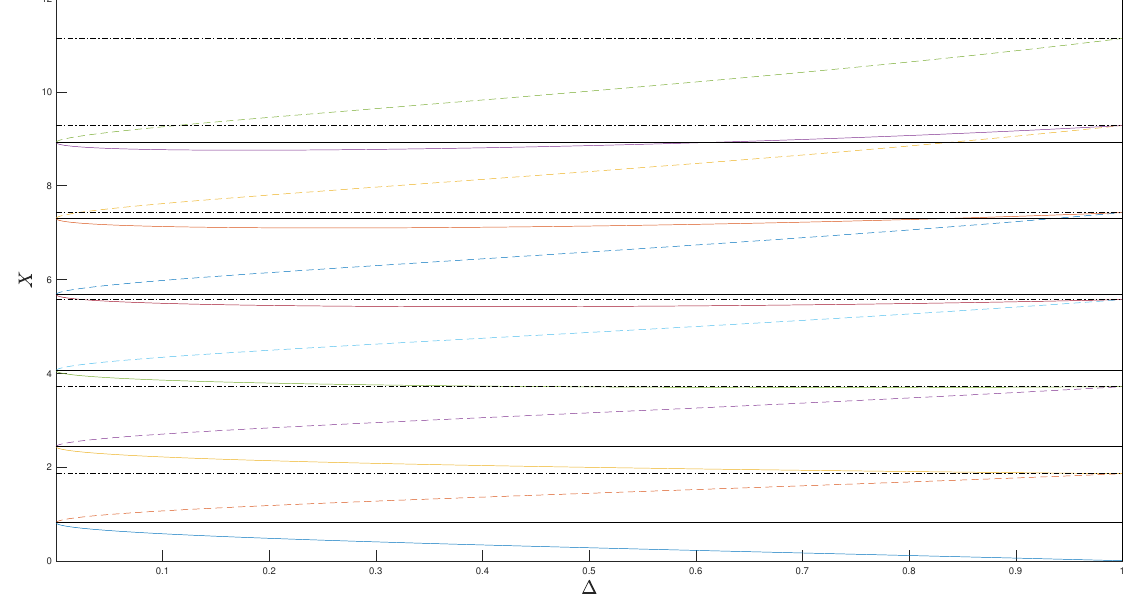
Figure A1. Plot of X SH m ( E 2 ) (solid lines) and X SOL m ( E 2 ) (dashed lines) as a function of ∆ ≡ ( E 2 − − E C ) in the range ∆ ∈ [ 0,1 ] . The horizontal solid and dashed-dotted lines correspond to the ) / ( E H E C 2 2 2 limit values X = X C m and X = X H m ,